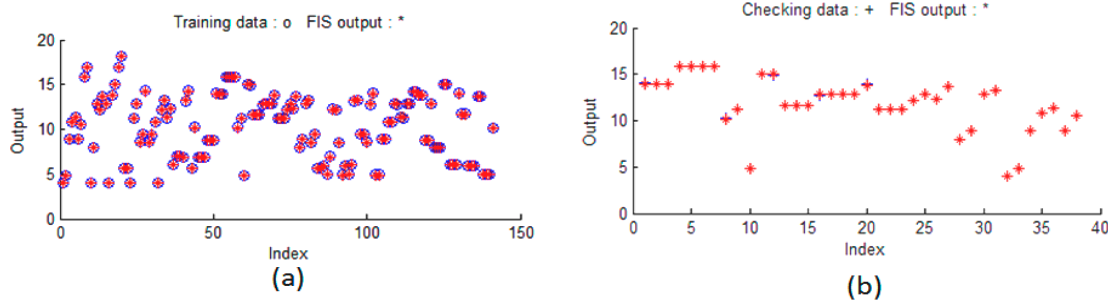
Figure 8. Comparison of predicted data ( a ) with training data and ( b ) with checking data. Table 3. Root mean square error table for training and validation of the models offered.